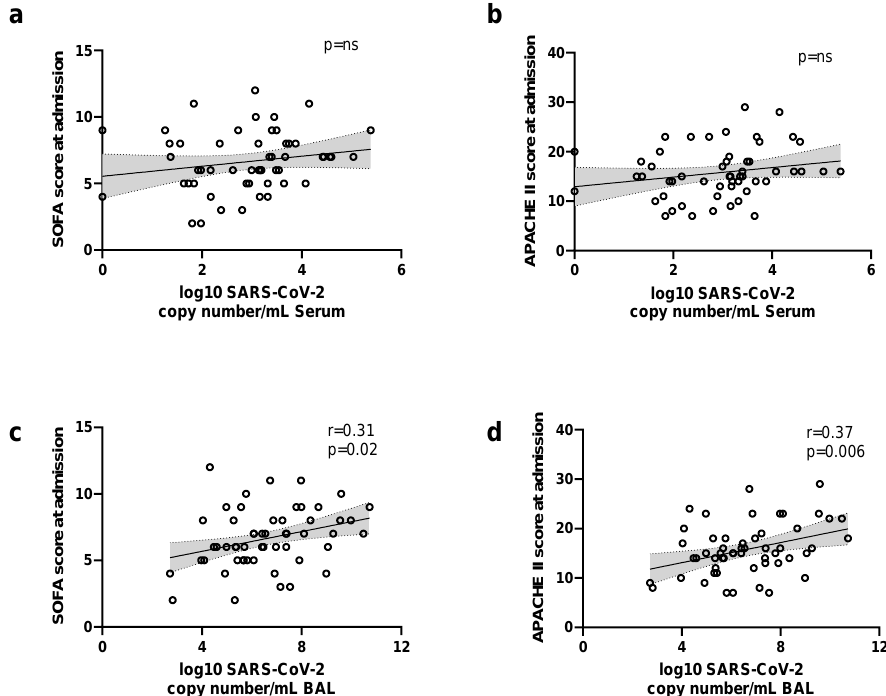
Figure 5. Correlation of earliest SARS-CoV-2 viral load in BAL and serum samples with severity scores at ICU admission. A linear regression and Pearson correlation analysis was performed between the earliest viral load in serum samples with SOFA ( a ) and APACHE II ( b ). Same analysis was performed between the earliest viral load in BAL samples with SOFA ( c ) and APACHE II ( d ). Dotted lines show the 95% CI.